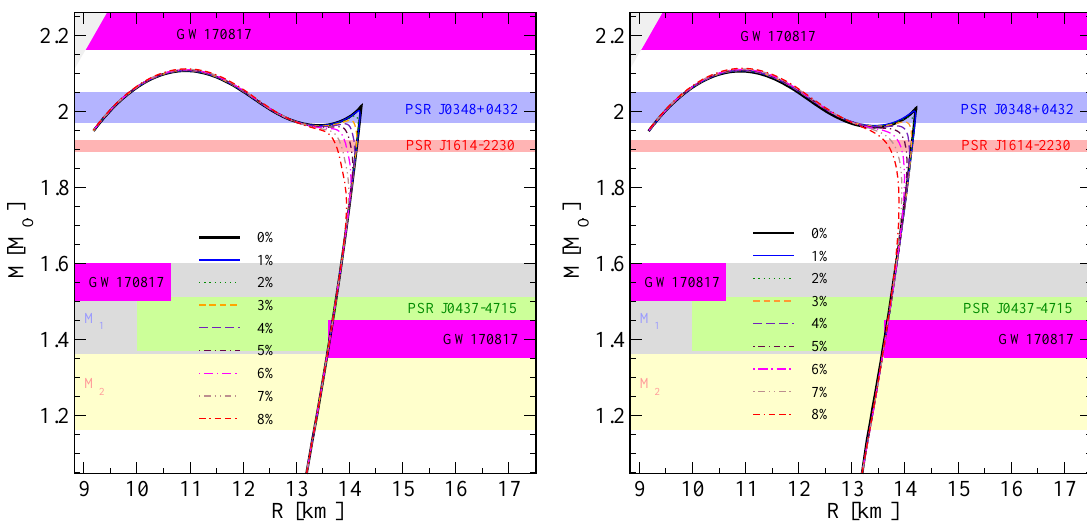
Figure 7. Mass-radius relations for both mixed phase approaches, MIM ( left panel ) and RIM for a sixth order polynomial ansatz ( right panel ). Each curve corresponds to an EoS with a chosen ∆ P value given as a percentage of the critical Maxwell pressure P c represented by alternating line-styles. The shaded areas correspond to compact star measurements: The blue and red horizontal bands correspond to mass measurements of PSR J1614-2230 [39] and PSR J0348+432 [40], respectively. The gray and orange bands denoted by M1 and M2 are the compact star mass windows for the binary merger GW170817. The green band corresponds to the 1.44 ± 0.07 M (cid:12) mass of PSR J0437-4715 whose radius is expected to be measured by NICER [41]. The hatched regions are excluded by GW170817: the star radius at 1.6 M (cid:12) cannot be smaller than 10.68 km [25] and for a 1.4 M (cid:12) the star has to have a radius smaller than 13.6km [3]. The maximum mass of compact stars is estimated to be lower than 2.16 M (cid:12)